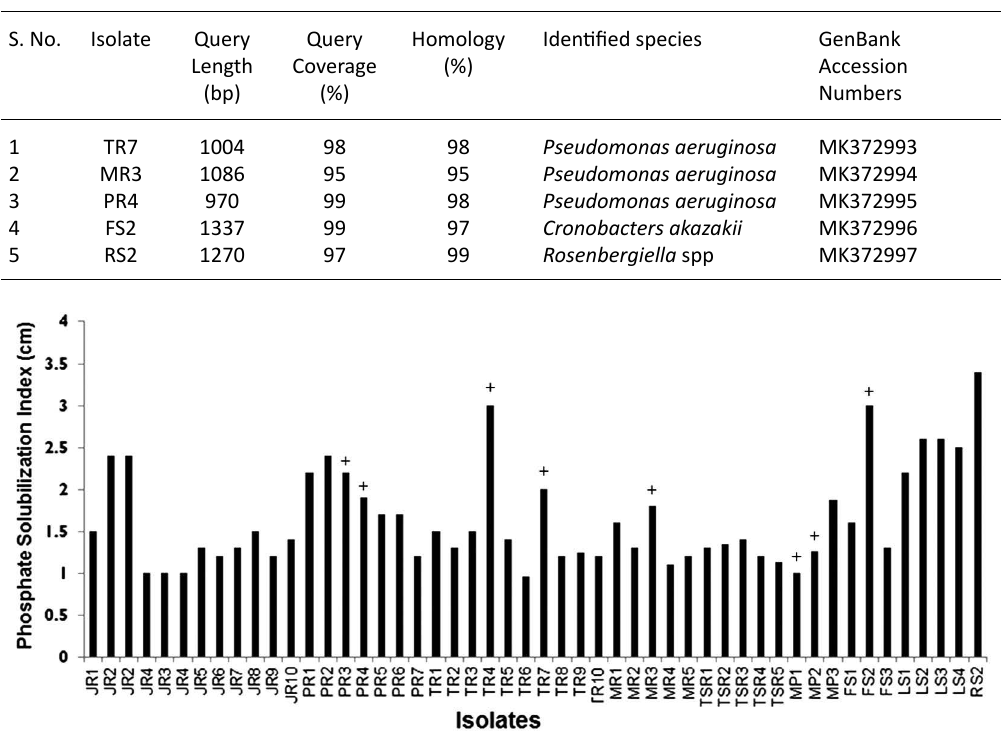
Fig. 1. Phosphate solubilisation indices of rhizospheric isolates Isolate codes depict the soil source as follows:MR-maize;JR-Jowar (sorghum); PR-Paddy; TR- Tobacco; MP-Money plant; TSR- Tea soil; LS-Lake side, RS- River side, FS-Factory side rhizospheres. + depicted above the bar for several isolate indicates presence of primary antibacterial ability; with that being absent in remaining unmarked isolates.